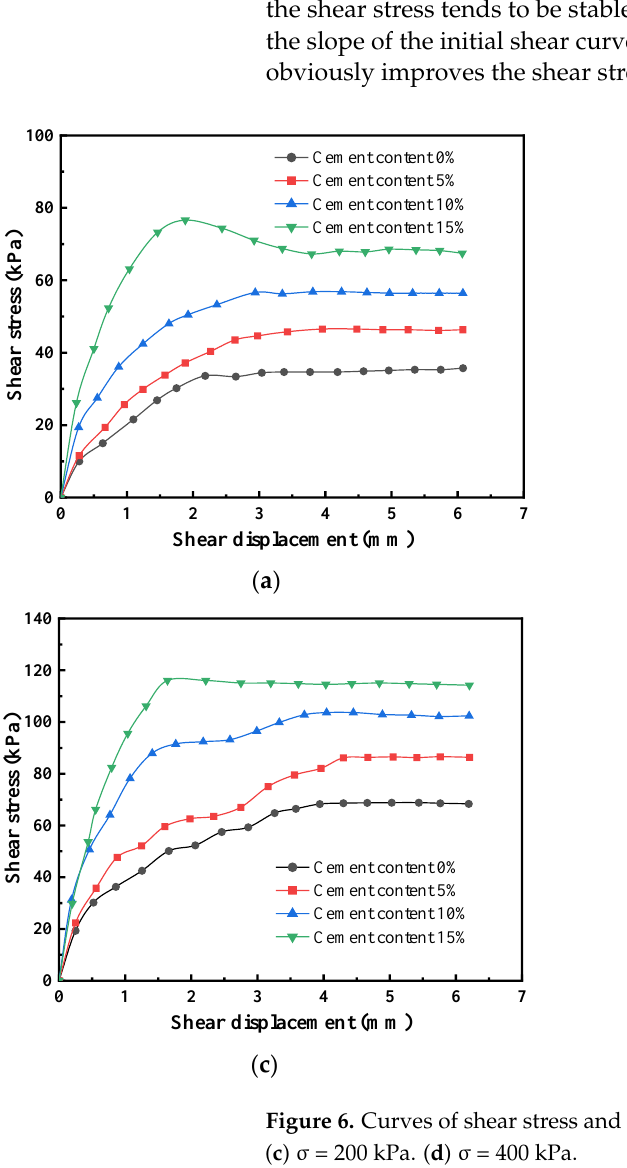
Figure 5. Relation between peak shear stress and grouting parameters.